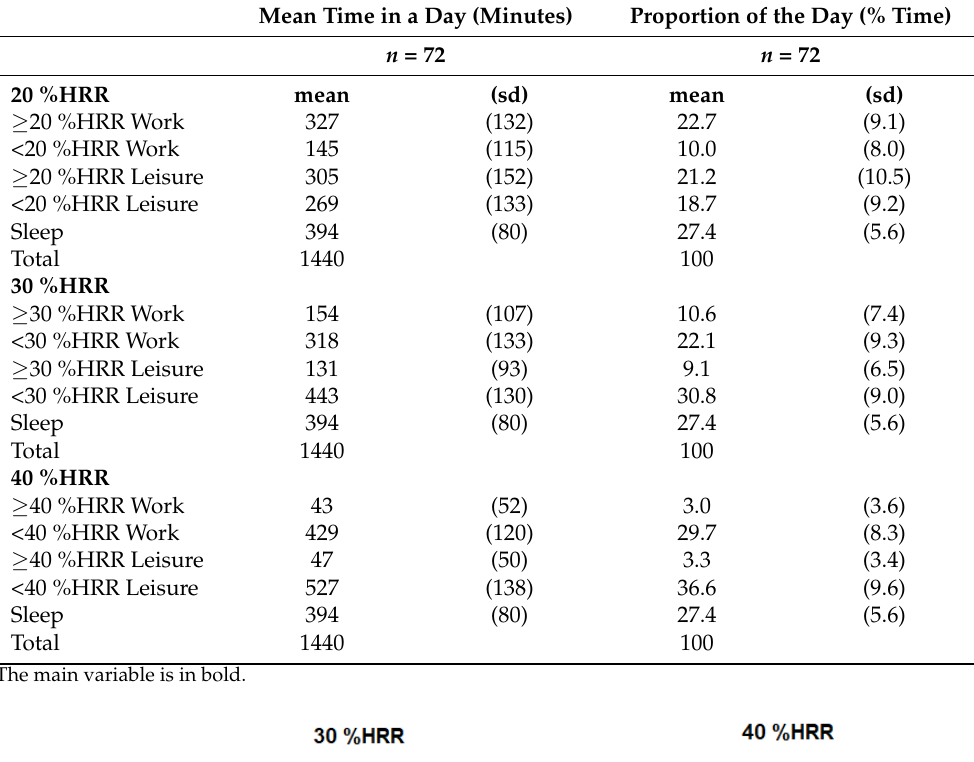
Table 2. Averages of time and percentage of time during a 24 h day spent in the physical activity categories and in sleep.